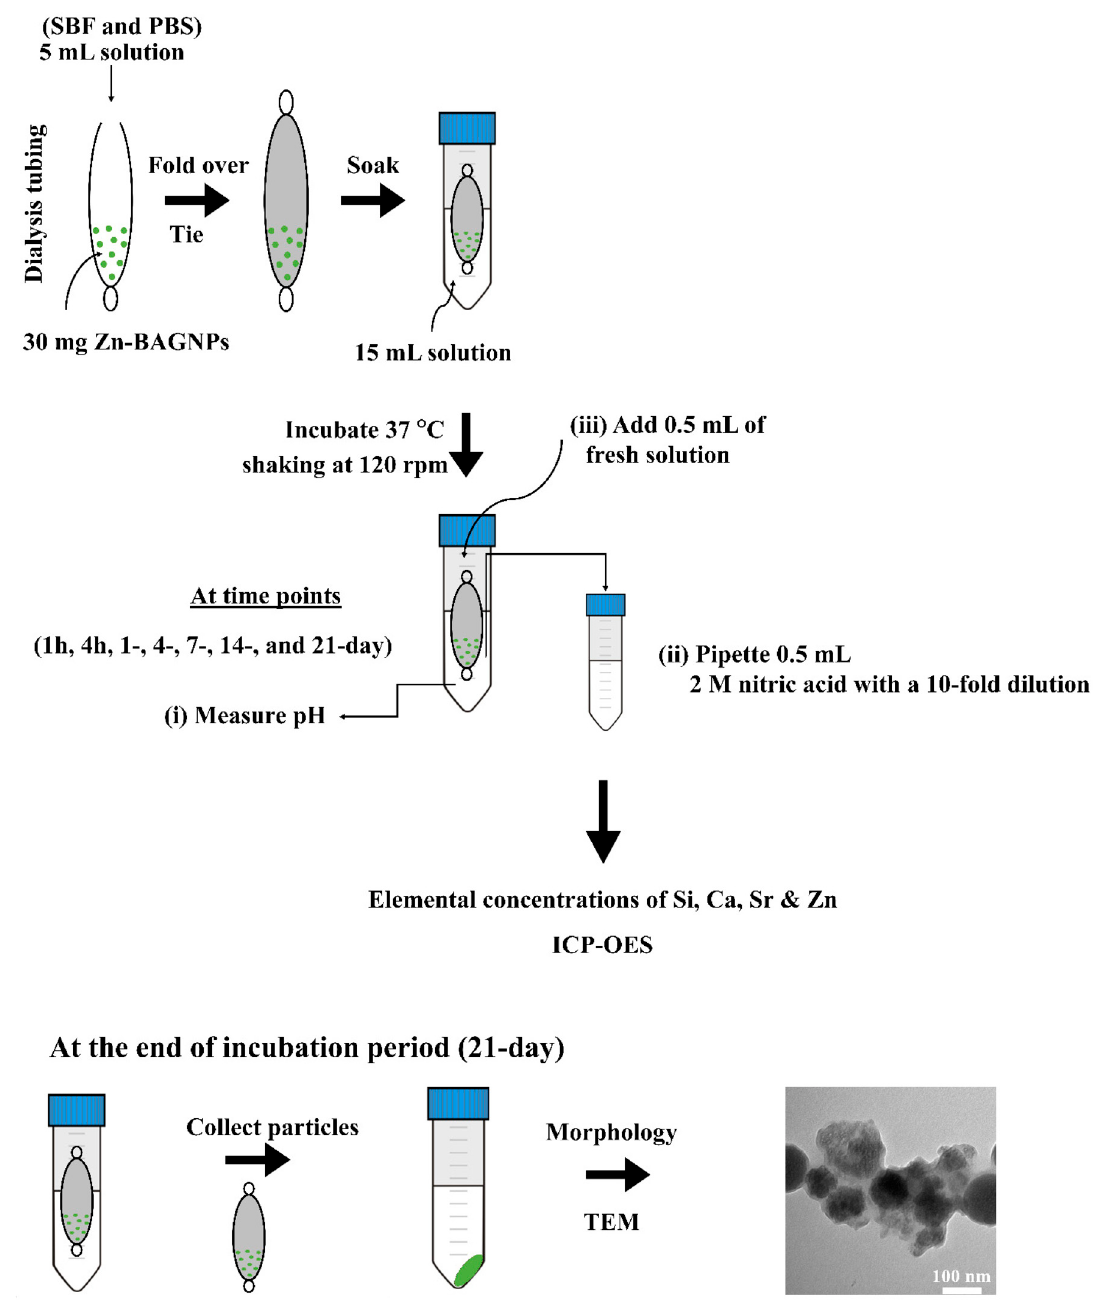
Scheme 3. Dissolution study of Zn-BAGNPs incubated in the simulated body fluid (SBF) at pH 7.4 and phosphate-buffered saline (PBS) at pH